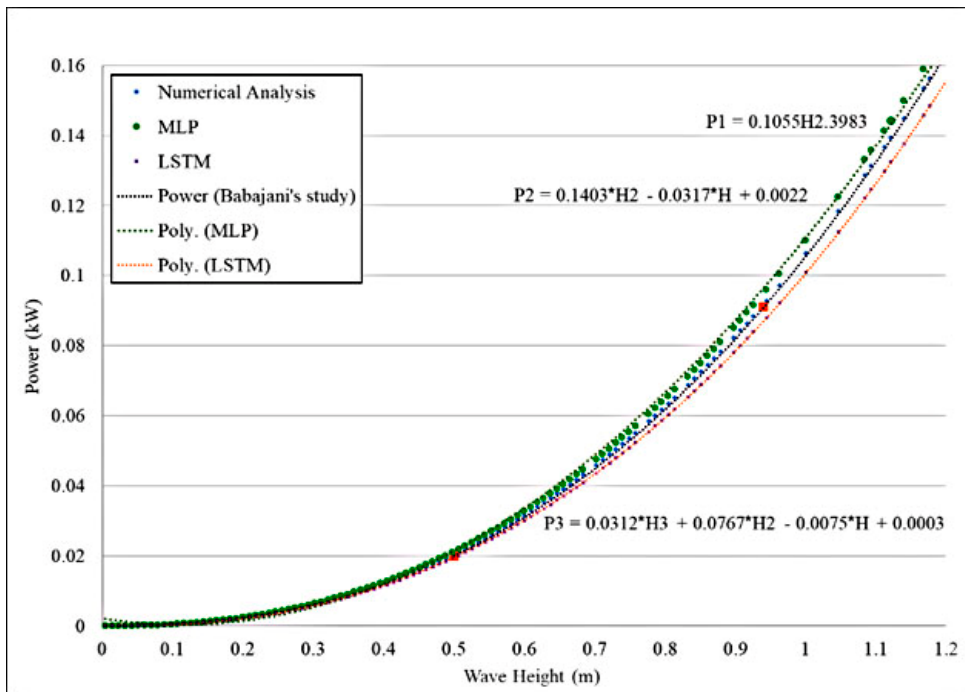
Figure 11. The comparison between two methods and their curve fitting.